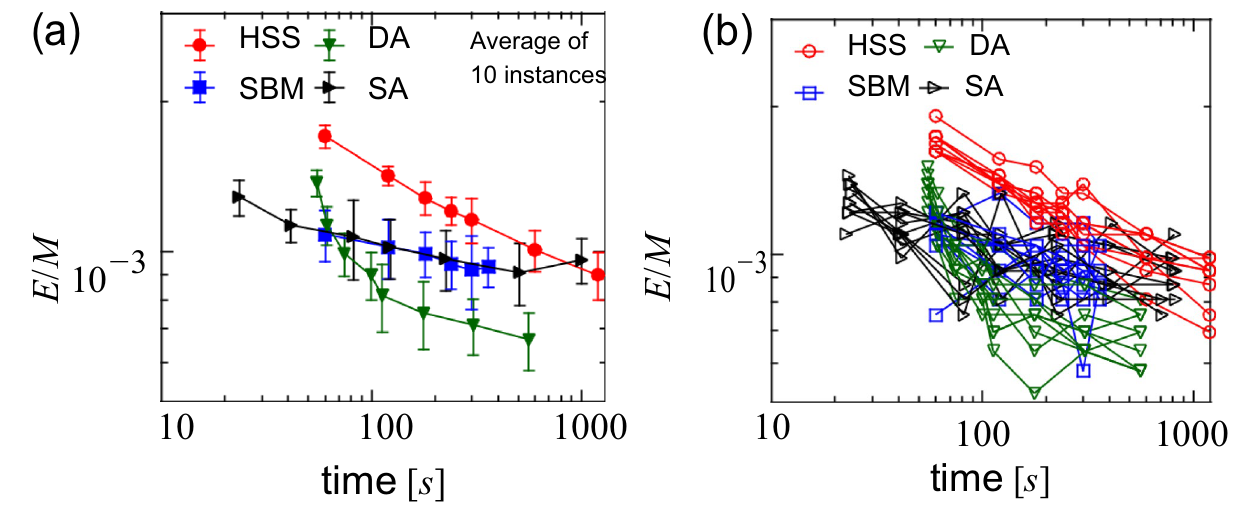
Figure 2. Value of the cost function per clause as a function of the execution time, obtained for NAE 3-SAT with a number of variables N = 8192 and a number of clauses M = 17,285, i.e., M/N ≈ 2.11. Each data point was obtained from an independent run. See the main text for the time metric of each solver. ( a ) Average of ten instances. The error bars denote standard deviation. For DA and SA, the execution time was also averaged. ( b ) Results for ten different instances.